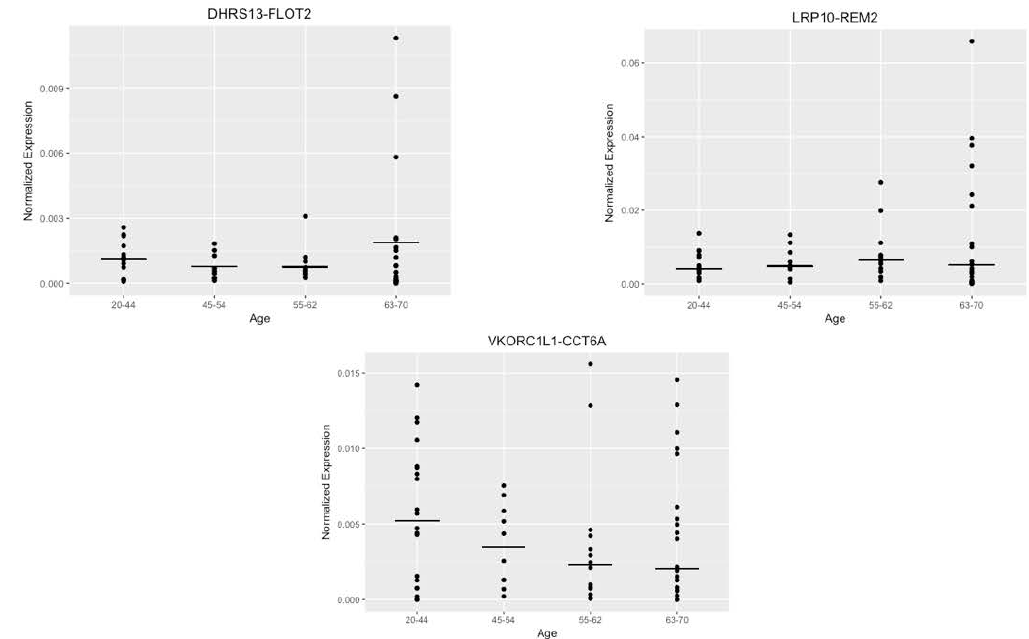
Figure 5. Alternate analysis of the fusion expression with age buckets. Dot plots representing distribution of normalized expression by age groups (20–44, 45–54, 55–62, 63–70) for DHRS13-FLOT2 , LRP10-REM2 (both forms), and VKORC1L1-CCT6A.